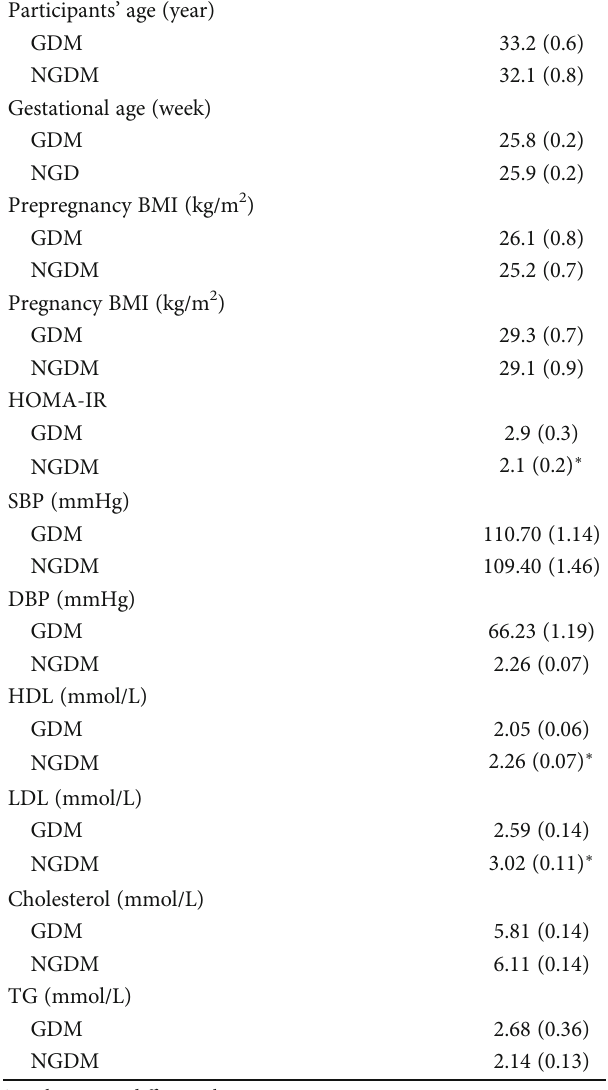
Table 1: Baseline characteristics of participants ( mean ± SE